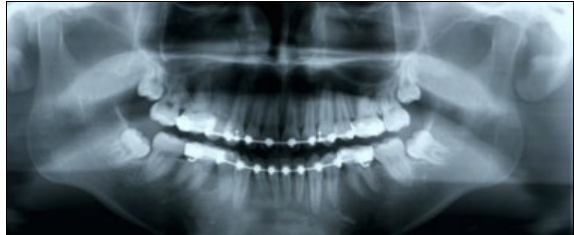
Figure 6. Fifty week progress OPG – showing interdental radiolucency between 44 and 46.